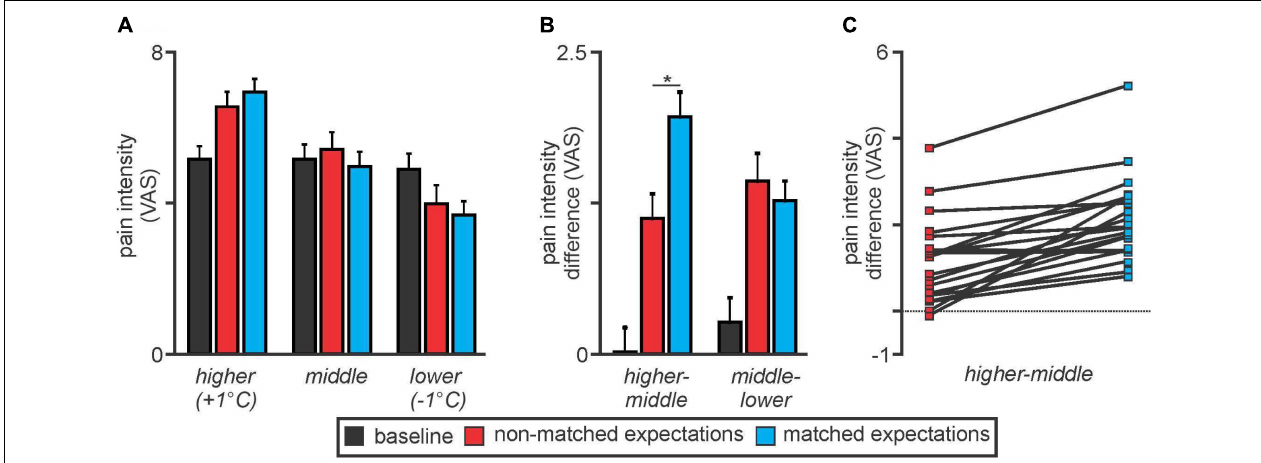
FIGURE 2 | (A) Pain intensity ratings on an 11-point visual analogue scale (VAS) during middle, higher, and lower thermal intensities during the baseline (black), non-matched expectations (red), and matched expectations (blue) scans. Note that pain intensity ratings during the middle stimuli intensity presentations were stable at approximately 5 out of 10. Pain intensity ratings increased during the higher stimulus intensities and decreased during the lower stimulus intensities during both the non-matched and matched expectations scans. (B) Differences in pain intensity ratings during the higher versus middle and middle versus lower stimulus intensities. Note that when the increase in stimulus intensity was not expected, subjects rated the pain lower than when the increase was expected (higher–middle). A similar difference did not occur when the stimulus intensity was lower (middle–lower). * p < 0.05. (C) Individual subject pain intensity rating differences between higher and middle stimulus intensities. Note that almost all subjects rated the + 1 ◦ C stimulus higher during matched compared with non-matched expectation trials.